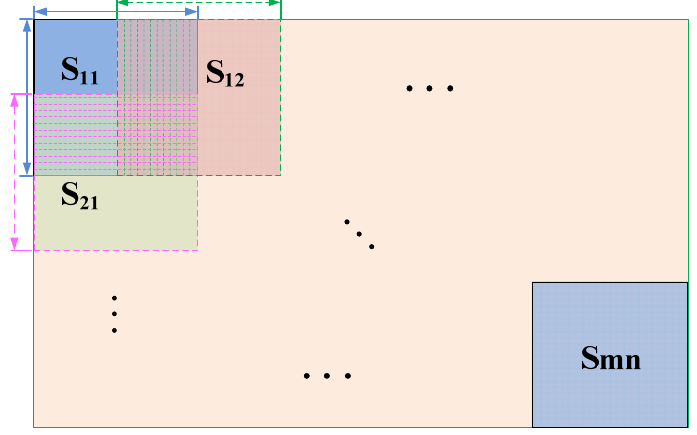
Figure 5. The sketch map of the splicing strategy.